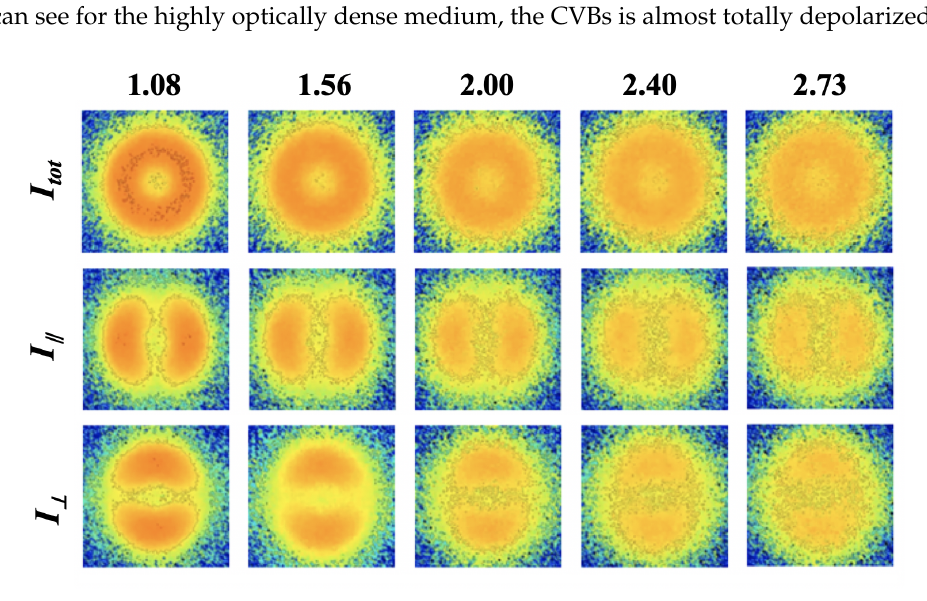
Figure 3. The results of simulation of I tot , co- I (cid:107) and cross- I ⊥ polarized components of a CVB with l = + 1, σ = − 1, transmitted through the scattering medium of various optical densities ( OD ): 1.08, 1.56, 2.00, 2.40, 2.73.